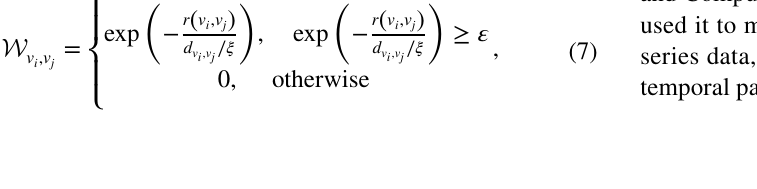
Fig. 1 Structure of STTF